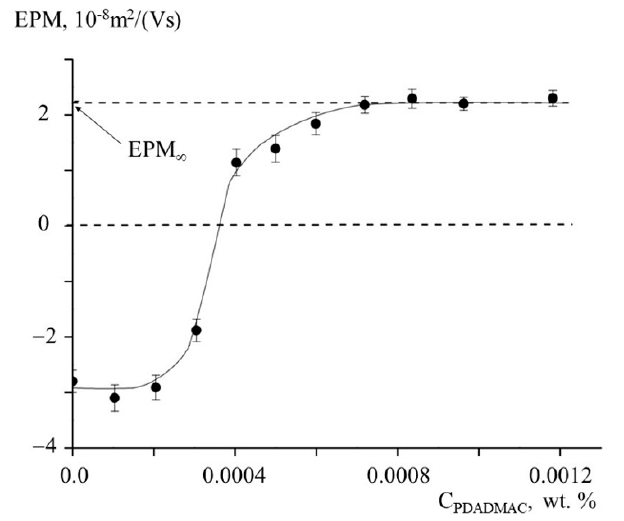
Figure 2. The dependences of electrophoretic mobility (EPM) of clay-PDADMAC suspensions on the concentration of aqueous PDADMAC solutions, C PDADMAC . 0.05 wt.% kaolinite aqueous sus- pension, pH =